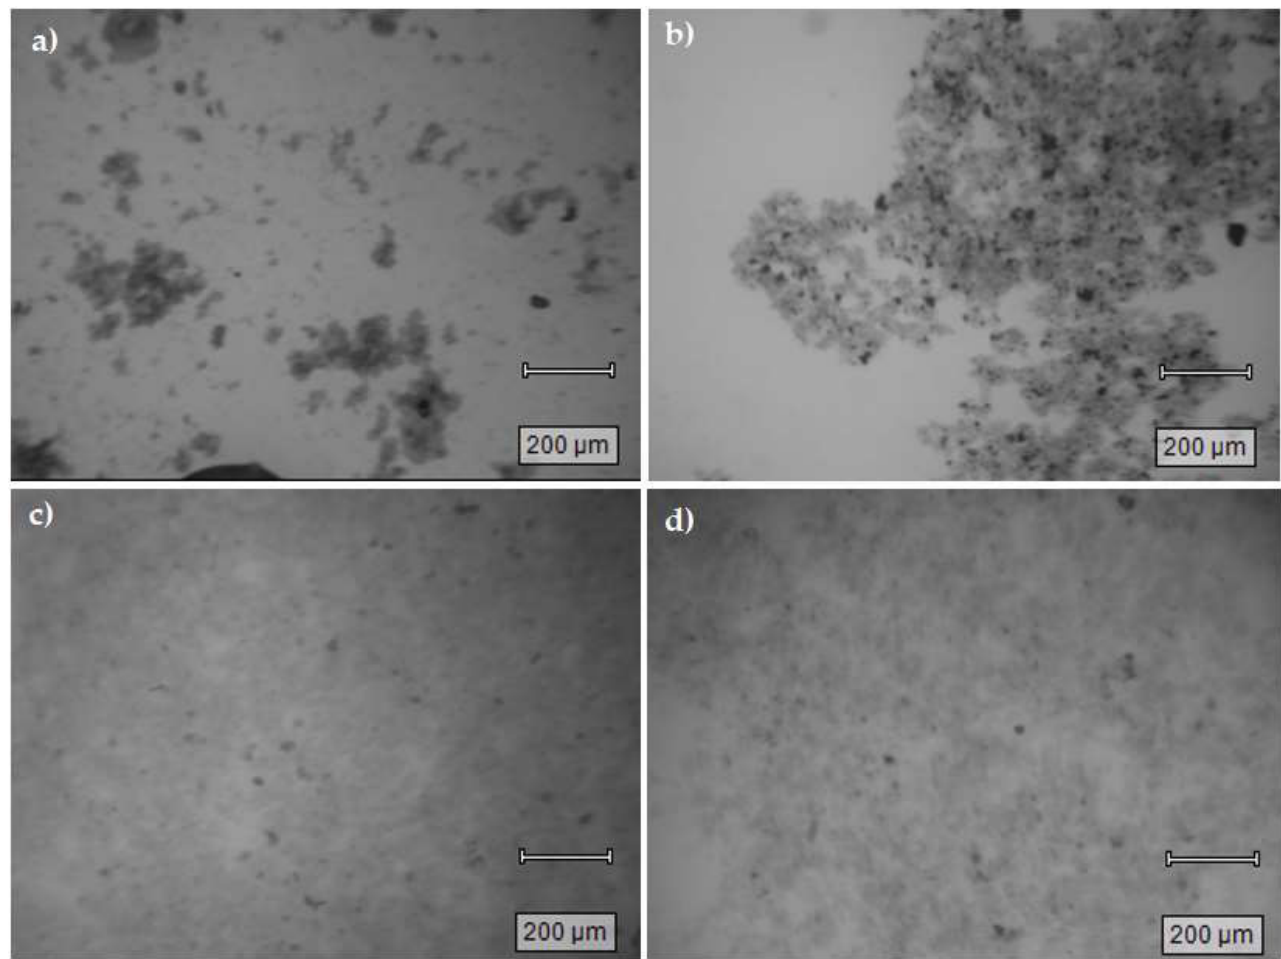
Figure 7. Floc sample images (5× magnification) obtained for variable coagulant systems: ( a ) naphthalene with lab water and ferric sulfate; ( b ) naphthalene with river water and ferric sulfate; ( c ) naphthalene with lab water and aluminum sulfate; ( d ) naphthalene with river water and aluminum